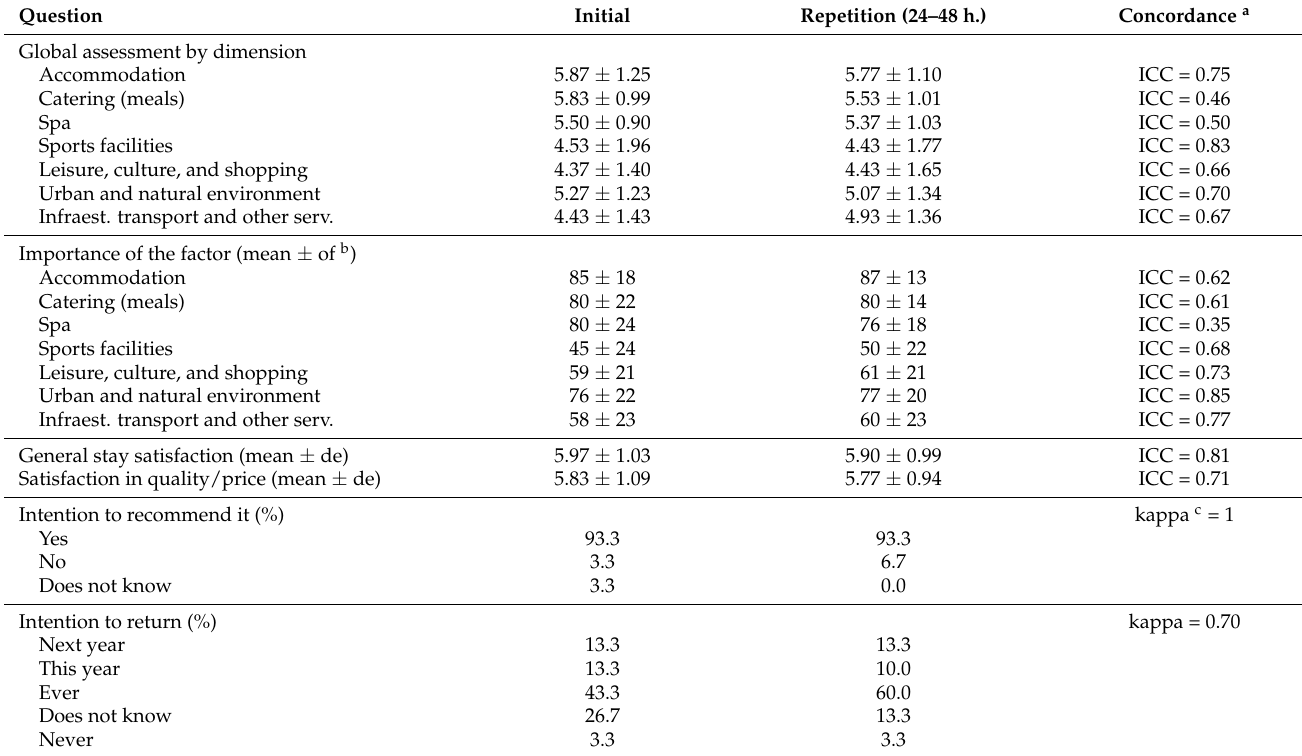
Table 4. Reliability of the questionnaire. General valuation questions. Test–retest with a separation between one and two days n =